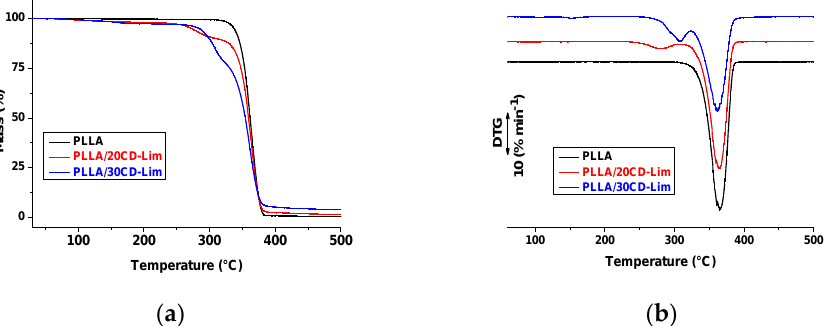
Figure 2. Thermogravimetric analysis of PLLA and PLLA/CD-Lim composites upon heating at 10 °C min −1 in nitrogen atmosphere: mass loss as a function of temperature ( a ) and the first derivative of the mass loss vs. temperature curves ( b ).